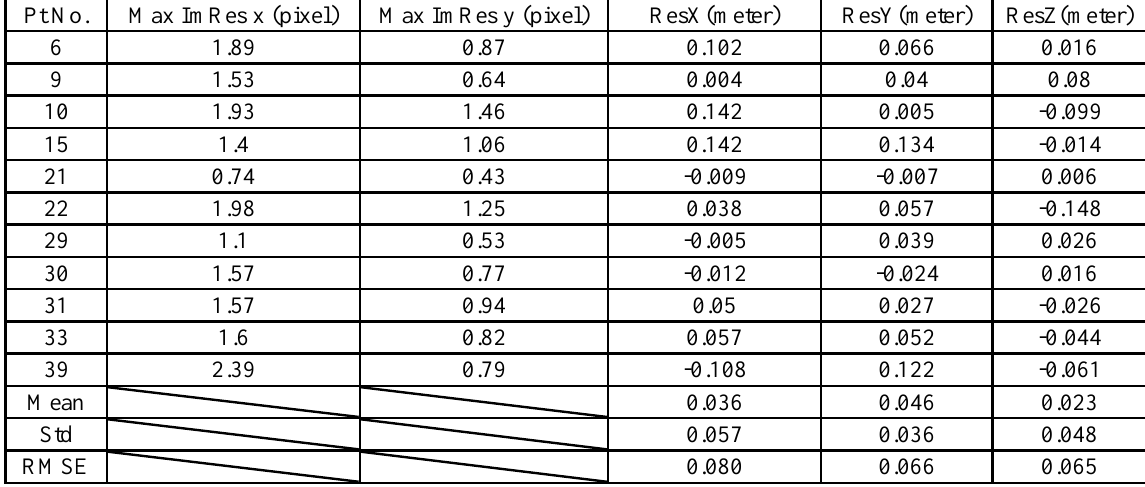
Figure 2: Layout of the NUS image block (left) and one sample image of a high-rise building (right). Table 1: Result of bundle adjustment of the full block with APERO. Residuals at check points. Pt